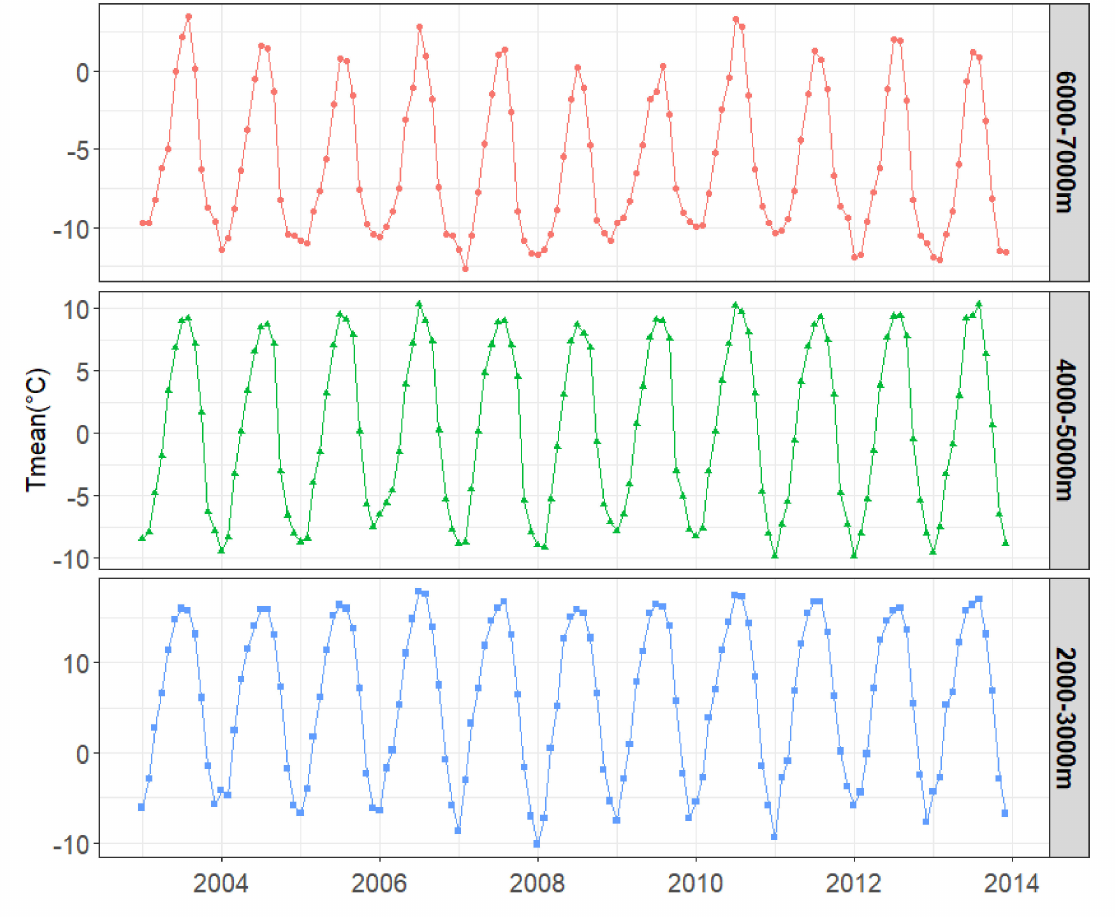
Figure 10. Tmean variation at three elevation zones from January 2003 to December 2013. The number of pixels within 1000 m elevation interval was extracted and each temperature change was computed from the mean of the